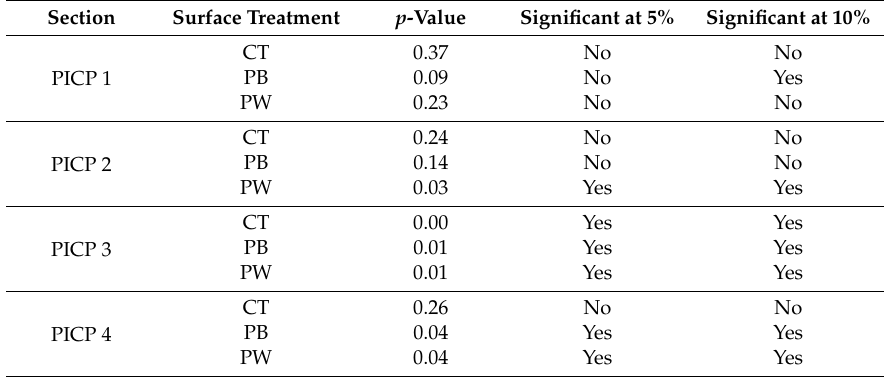
Table 8. Results of one-sided generalized Wilcoxon test for effect of each surface treatment.